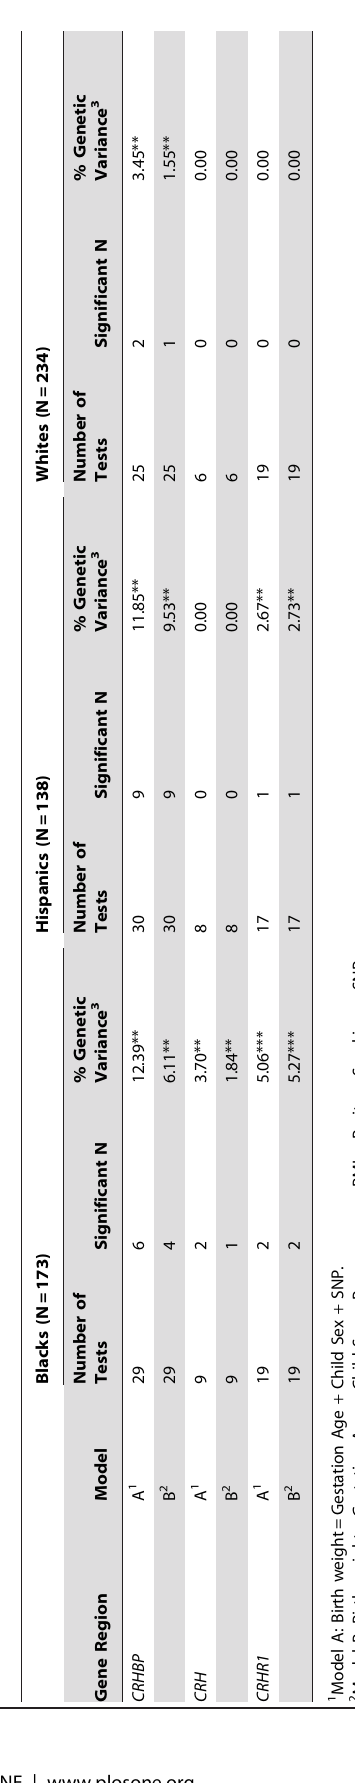
(CRH-BP) made a significant contribution in Whites (Table 3). SNPs to explaining birth weight variation ranged from 3.45% and 1.55% for models A and B, respectively, for White infants to 12.39% and 6.11% for models A and B, respectively, for Black infants. SNP variation in the CRH-BP gene region explained 6.11%, 9.53% and 1.55% of birth weight variation adjusted for the complete set of risk factors in Blacks, Hispanics and Whites, respectively. The SNPs that were selected to represent the contribution of each gene region to explaining variation in birth weight beyond that explained by either Model A or Model B for each race are listed in Table 4.